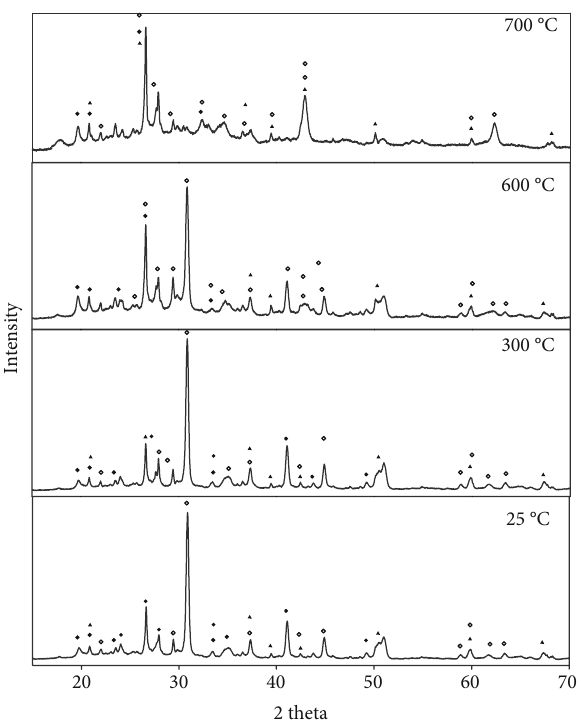
Figure 1: XRD patterns of MNZ/Fe samples for uncalcined at 25 ° C and calcined at 300, 600, and 700 ° C: ● : heulandite, ○ : mordenite, ♦ : erionite, ♢ : cristobalite, ▲ :